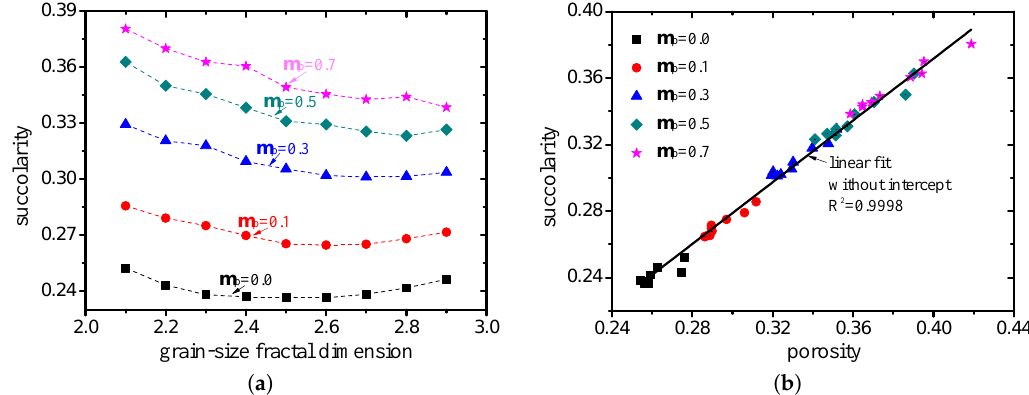
Figure 17. Variation in succolarity with ( a ) grain size fractal dimension and ( b ) porosity.